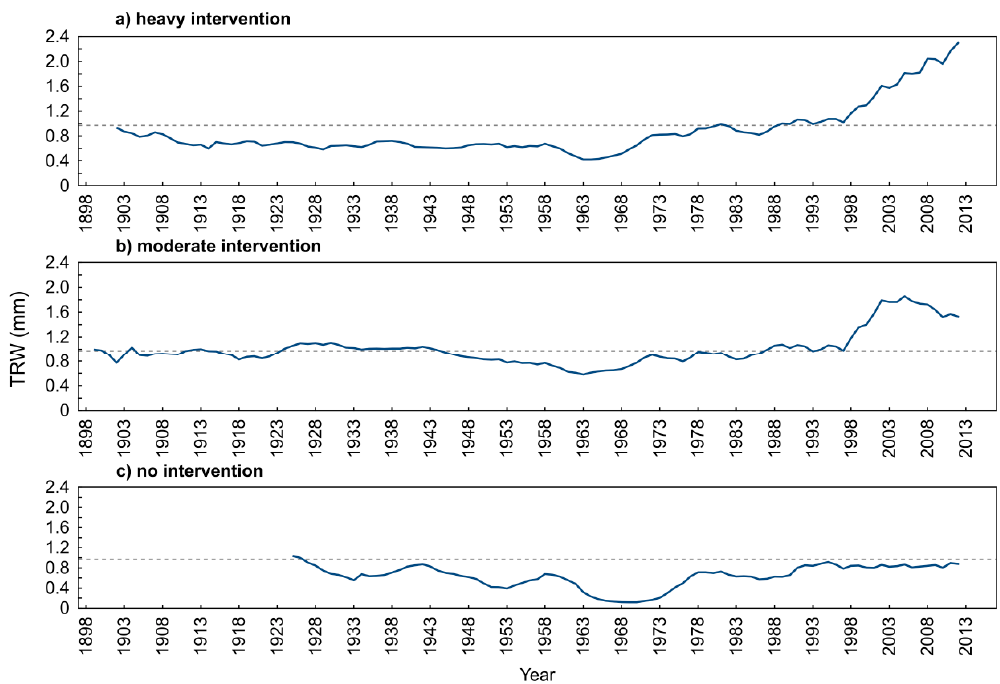
Figure 6. Comparison of mean periodic radial increments according to sex. Boxes represent standard deviations and whiskers range of TRW values; * denotes a significant difference between male and female yews.